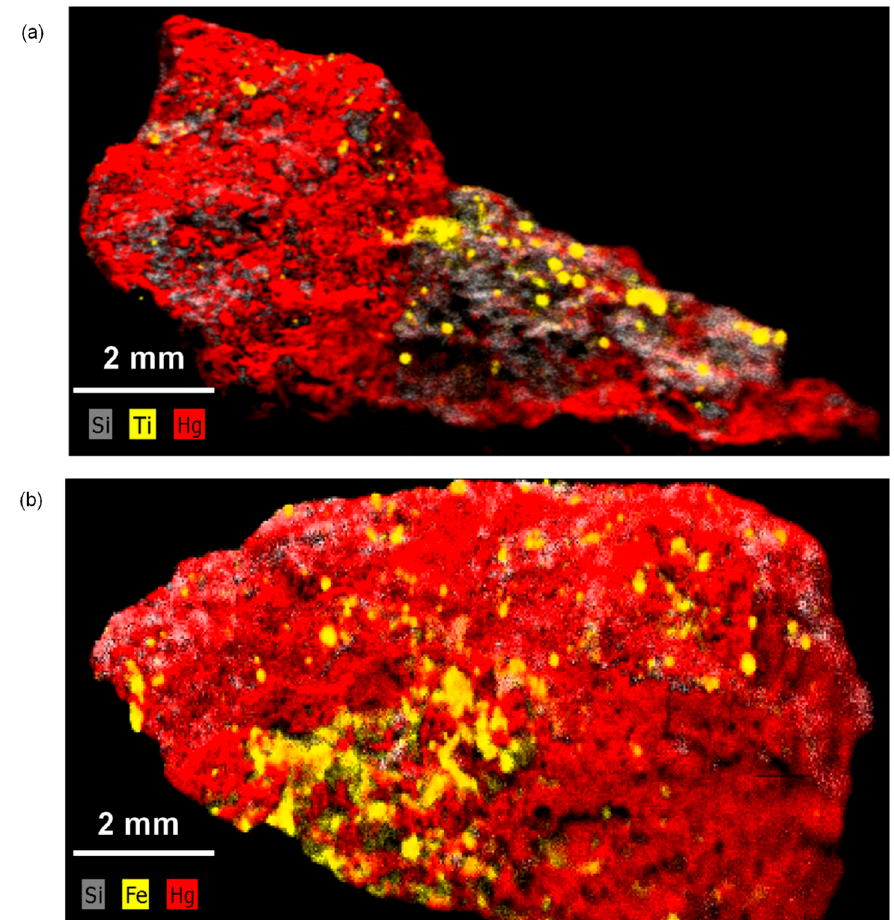
Figure 8. Elemental distribution maps obtained by µ-EDXRF showing ( a ) the distribution of Hg, Si and Ti on a fragment from the Almadén ore, ( b ) the distribution of Hg, Si and Fe on a fragment from the El Entredicho ore.